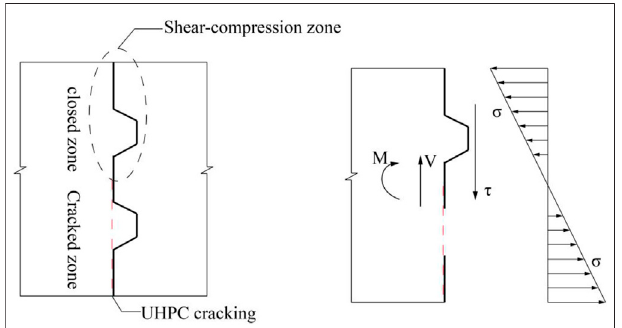
FIGURE 8 | Calculation diagram of epoxy adhesive